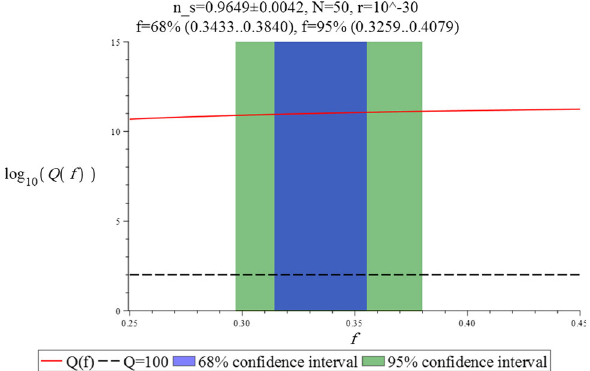
Fig. 5 Therearetwoimportantregionsinthisplot.Thefirstisbetween black-dashed and red lines where the model is in landscape and com- patible with observation but not matched with TCC bound (20). The second region is upper than the red line which is also compatible with TCC, observation, and out of swampland